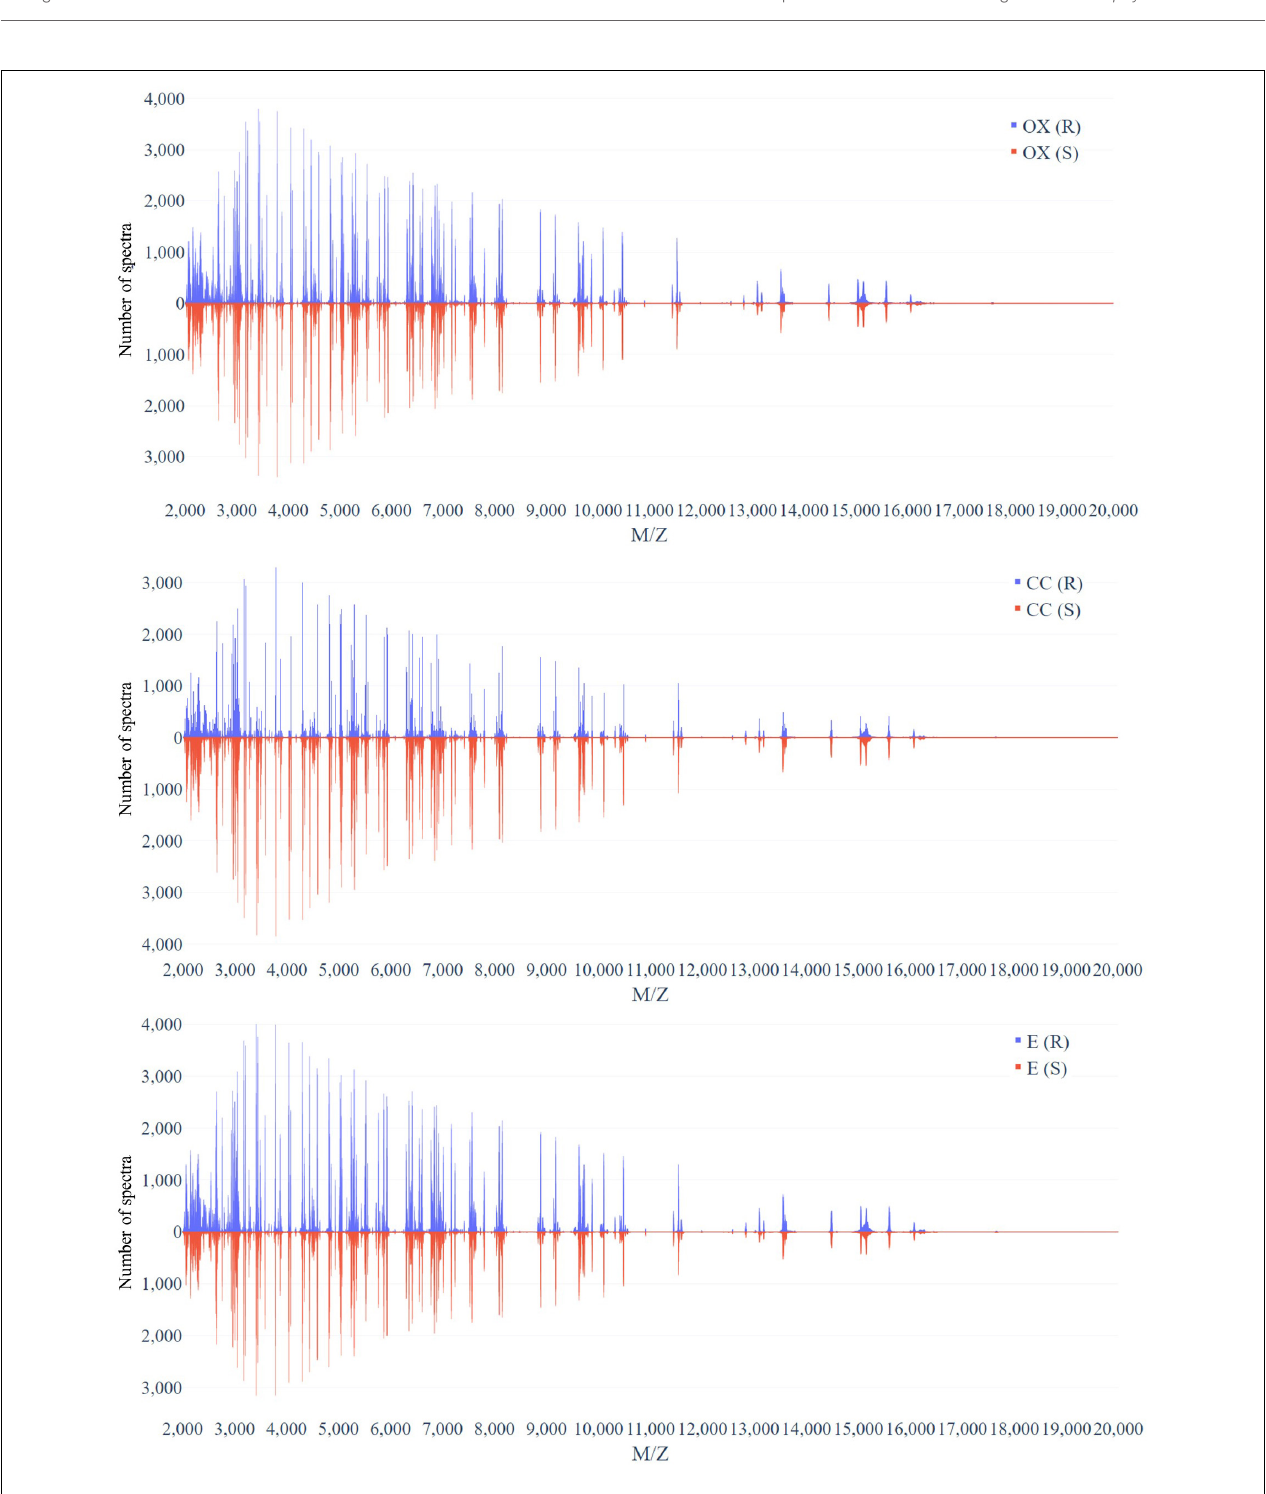
FIGURE 3 | Distribution of number of spectra that were derived from oxacillin- (upper), clindamycin- (middle), and erythromycin-resistant/susceptible (bottom) Staphylococcus aureus isolates at each M/Z.